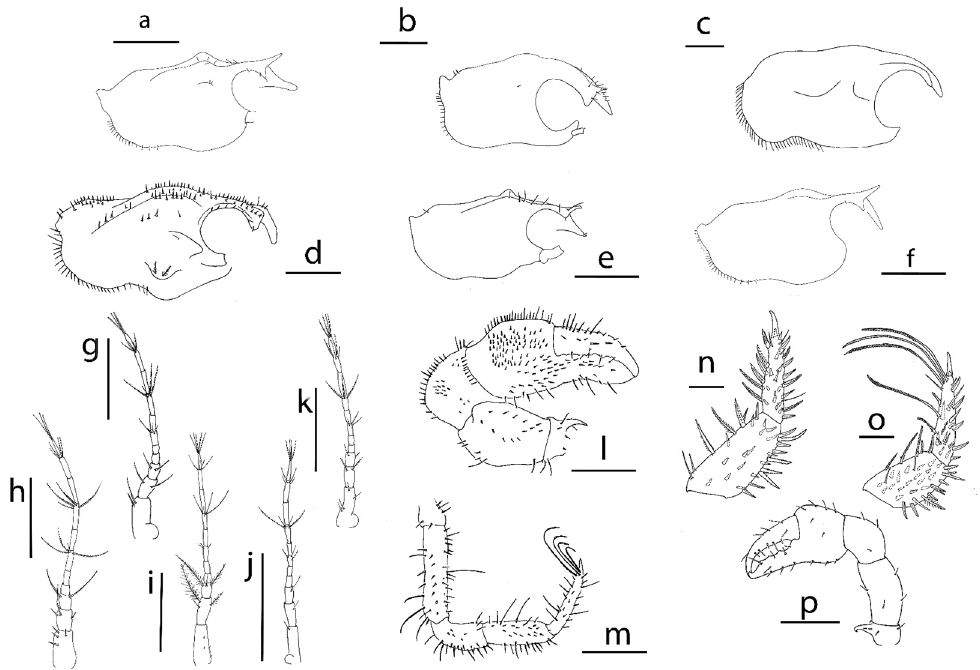
Figure 7. Lateral view of megalopa: ( a ) Neoliomera cerasinus; ( b ) Liomera cinctimanus; ( c ) Pseudoliomera variolosa ; ( d ) Williamstimpsonia stimpsoni ; ( e ) Scopolius nuttingi; ( f ) Etisus odhneri. Antenna: ( g ) Liomera cinctimana; ( h ) Pseudoliomera variolosa ; ( i ) Williamstimpsonian stimpsoni ; ( j ) Scopolius nuttingi ; ( k ) Etisus odhneri . Cheliped: ( l ) Williamstimpsonian stimpsoni ; ( p ) Etisus odhneri. Fifth pereiopod: ( m ) Williamstimpsonian stimpsoni ; ( o ) Pseudoliomera variolosa . Dactylus of second pereiopod: ( n ) Pseudoliomera variolosa . Scale bars: 0.5 mm.